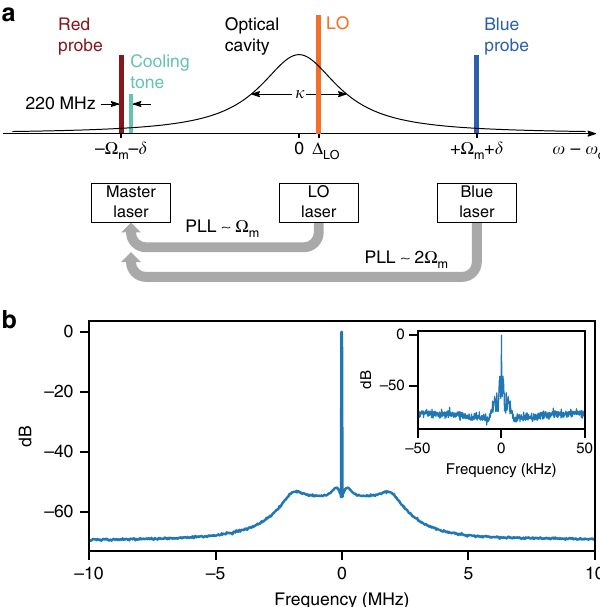
Fig. 5 Complete frequency setup and phase-locked loop beat note. a The frequencies of the various tones used in the experiment. The cavity has resonance frequency ω c and linewidth κ . The mechanical resonance frequency is Ω m . The probes are applied with small detuning δ from the upper and lower mechanical sidebands. An additional cooling tone is applied as shown. The local oscillator (LO), which does not enter the cavity, is detuned by Δ LO from cavity resonance. b A typical out-of-loop PLL beat note, relative to the offset frequency. The resolution bandwidth (RBW) is 6.25 kHz. The inset shows a zoom-in with RBW of 31.25